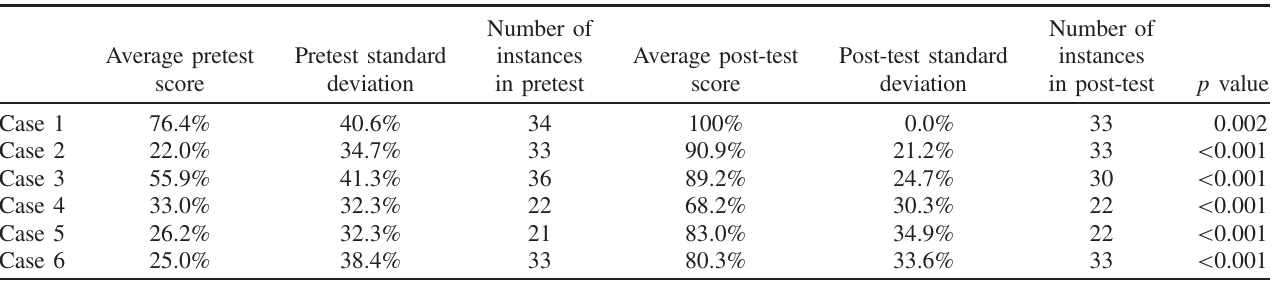
TABLE II. Summary of the average score, standard deviation and number of instances of each of these cases present in both the pretest and